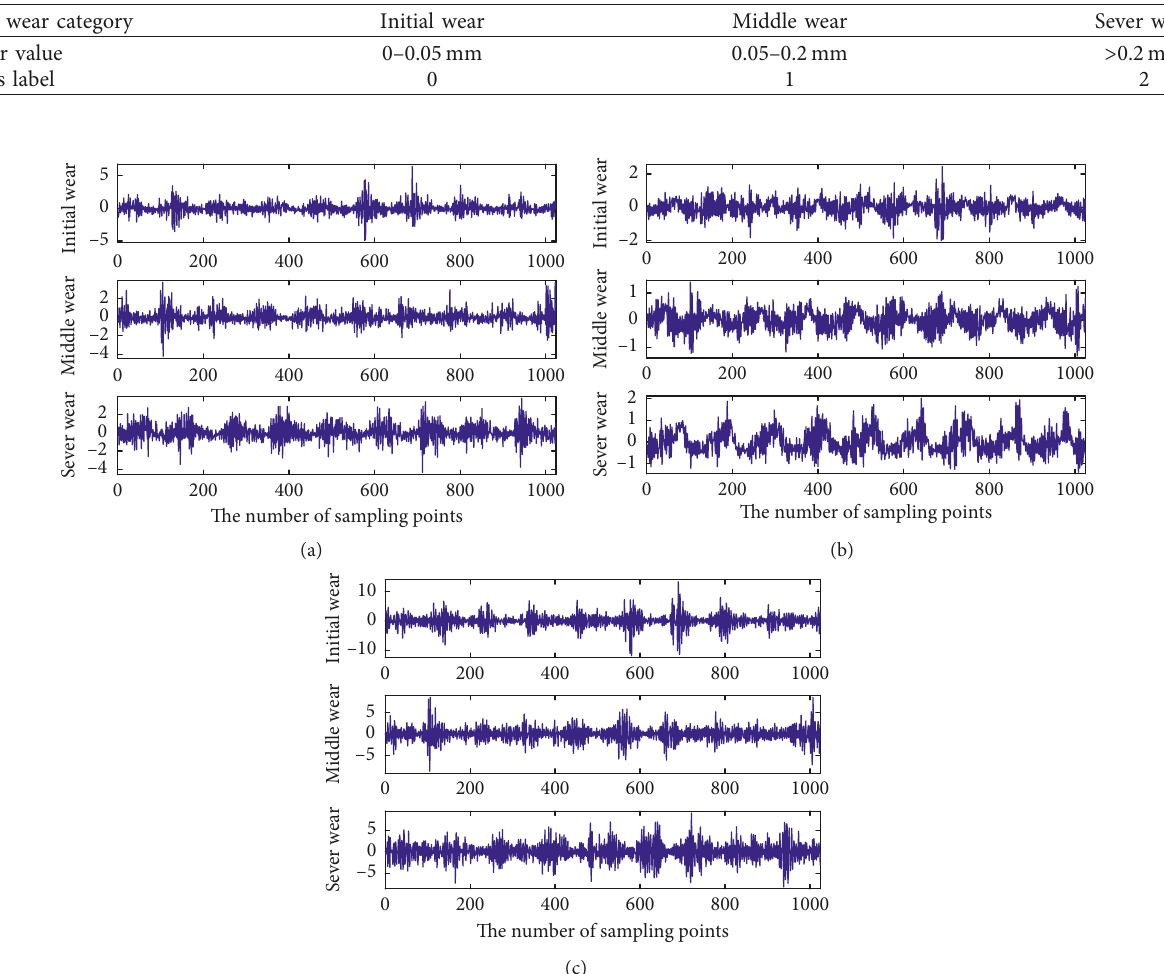
Figure 6: Vibration signal waveform in different milling tool wear states: (a) X -directional vibration signals, (b) Y -directional vibration signals, and (c) Z -directional vibration signals.